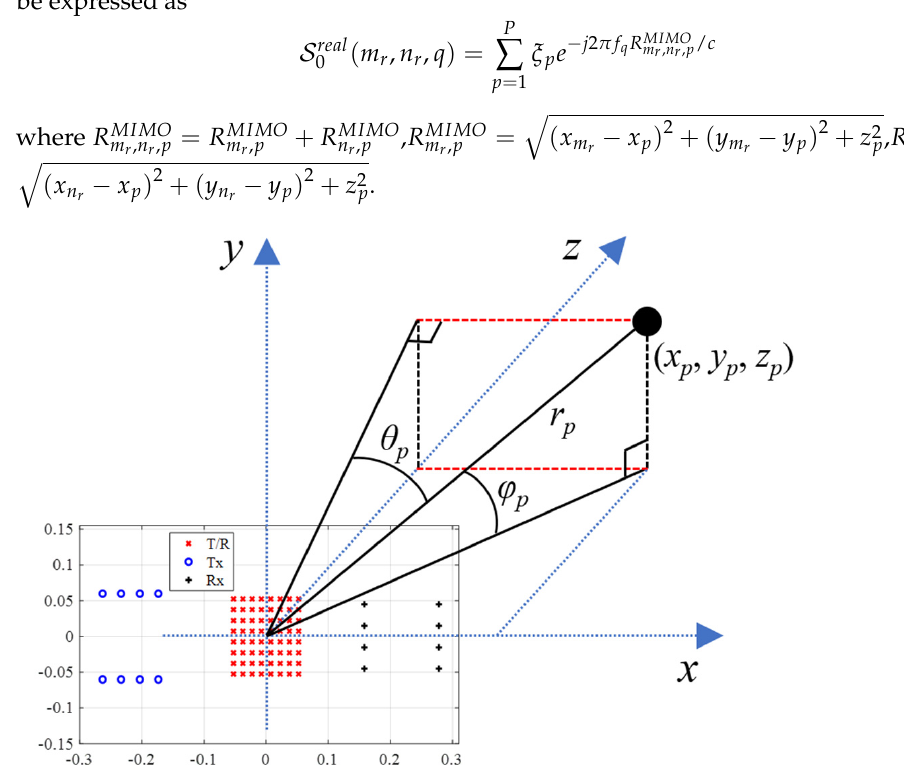
Figure 28. SDR-MIMO radar array structure and imaging geometry.